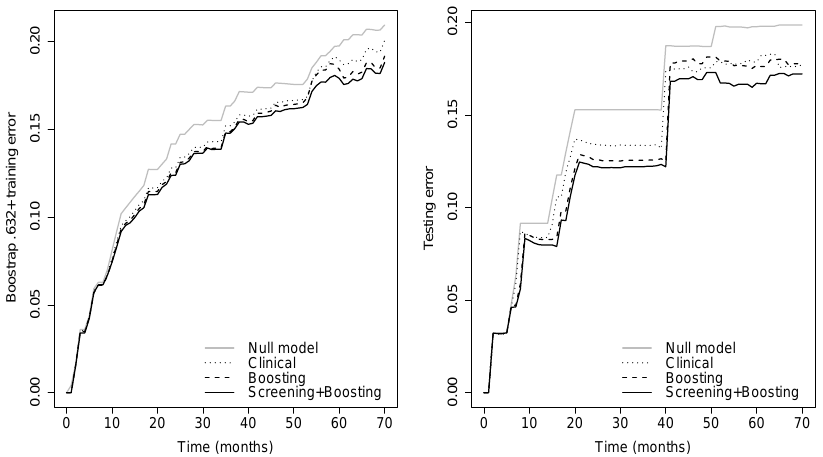
Figure 2. Bootstrap .632+ training error curve ( left panel ) and testing error curve ( right panel ) for prediction of the cumulative incidence function.